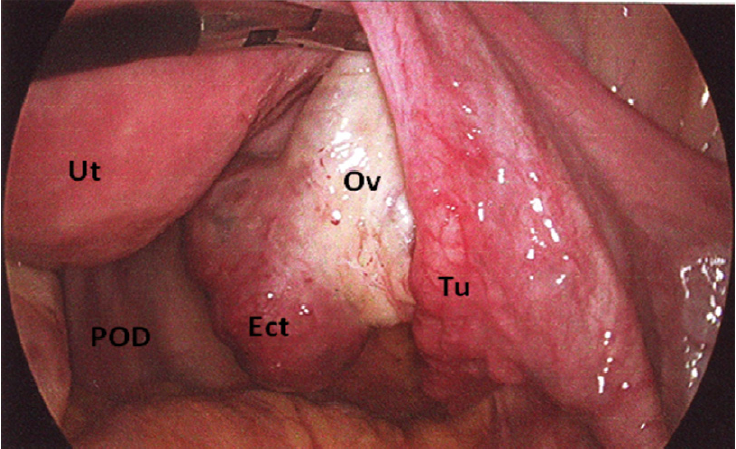
Figure 2. Laparoscopic view of an unruptured right ovarian ectopic pregnancy. (Ut = uterus, POD = pouch of Douglas, Ect = ectopic pregnancy, Ov = right ovary, Tu = Fallopian